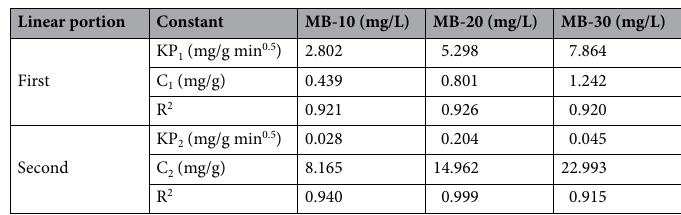
Table 3. Intra-particle diffusion model for different concentration of